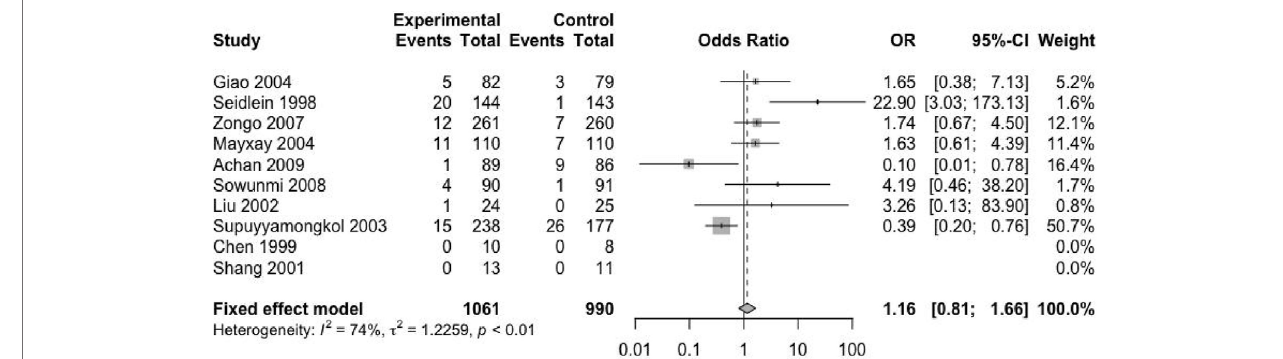
FIGURE 4 | Second malaria attack rate.